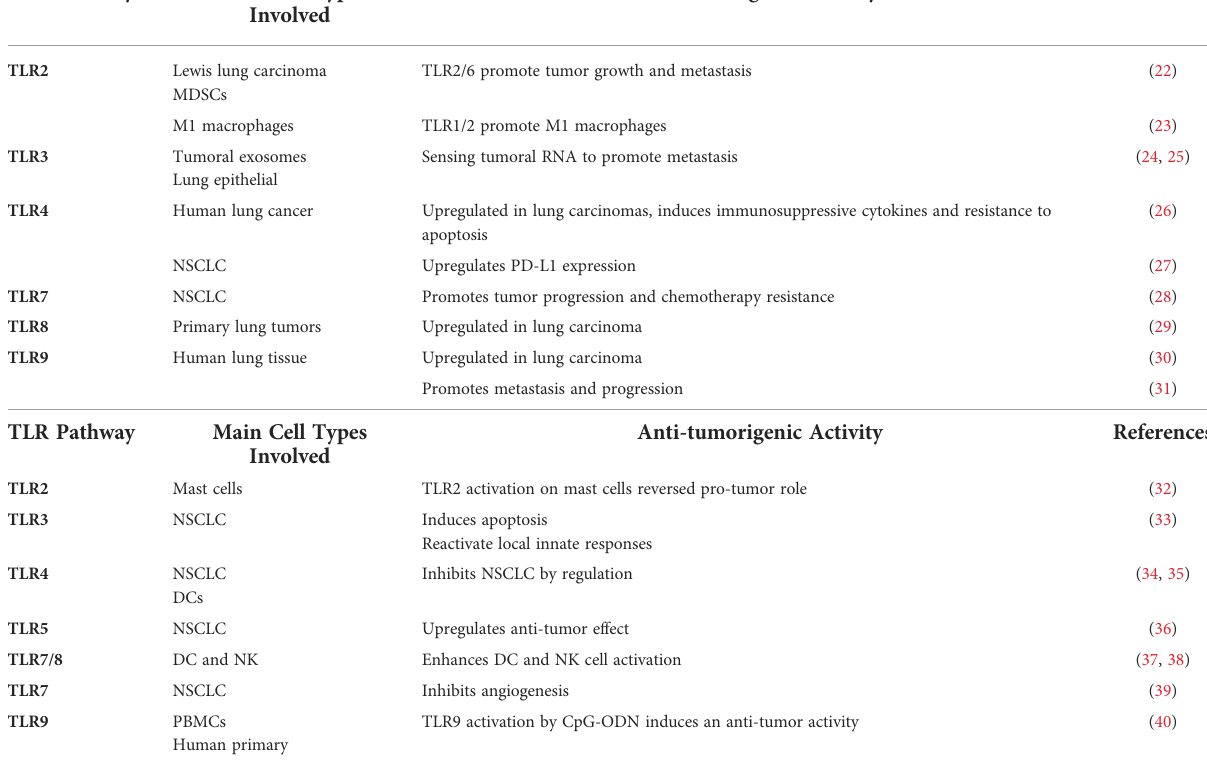
TABLE 1 Roles of TLRs in lung